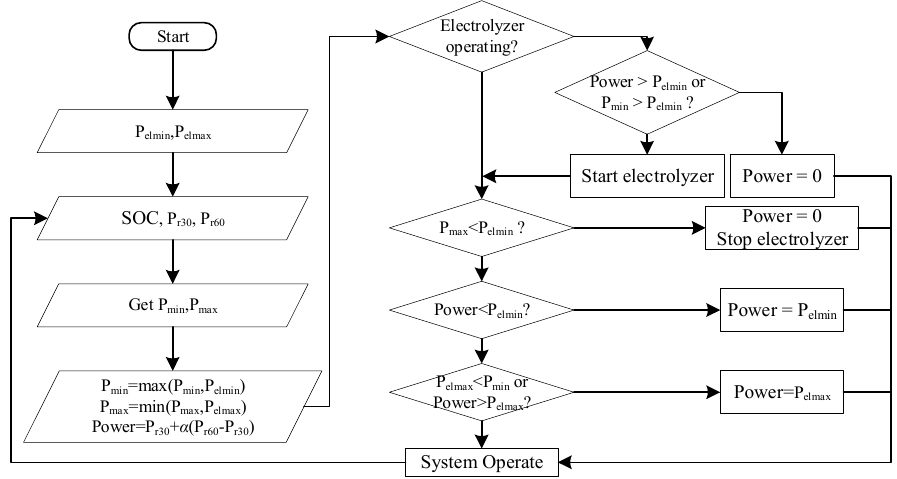
Figure 6. Energy management strategy of the hydrogen production system.